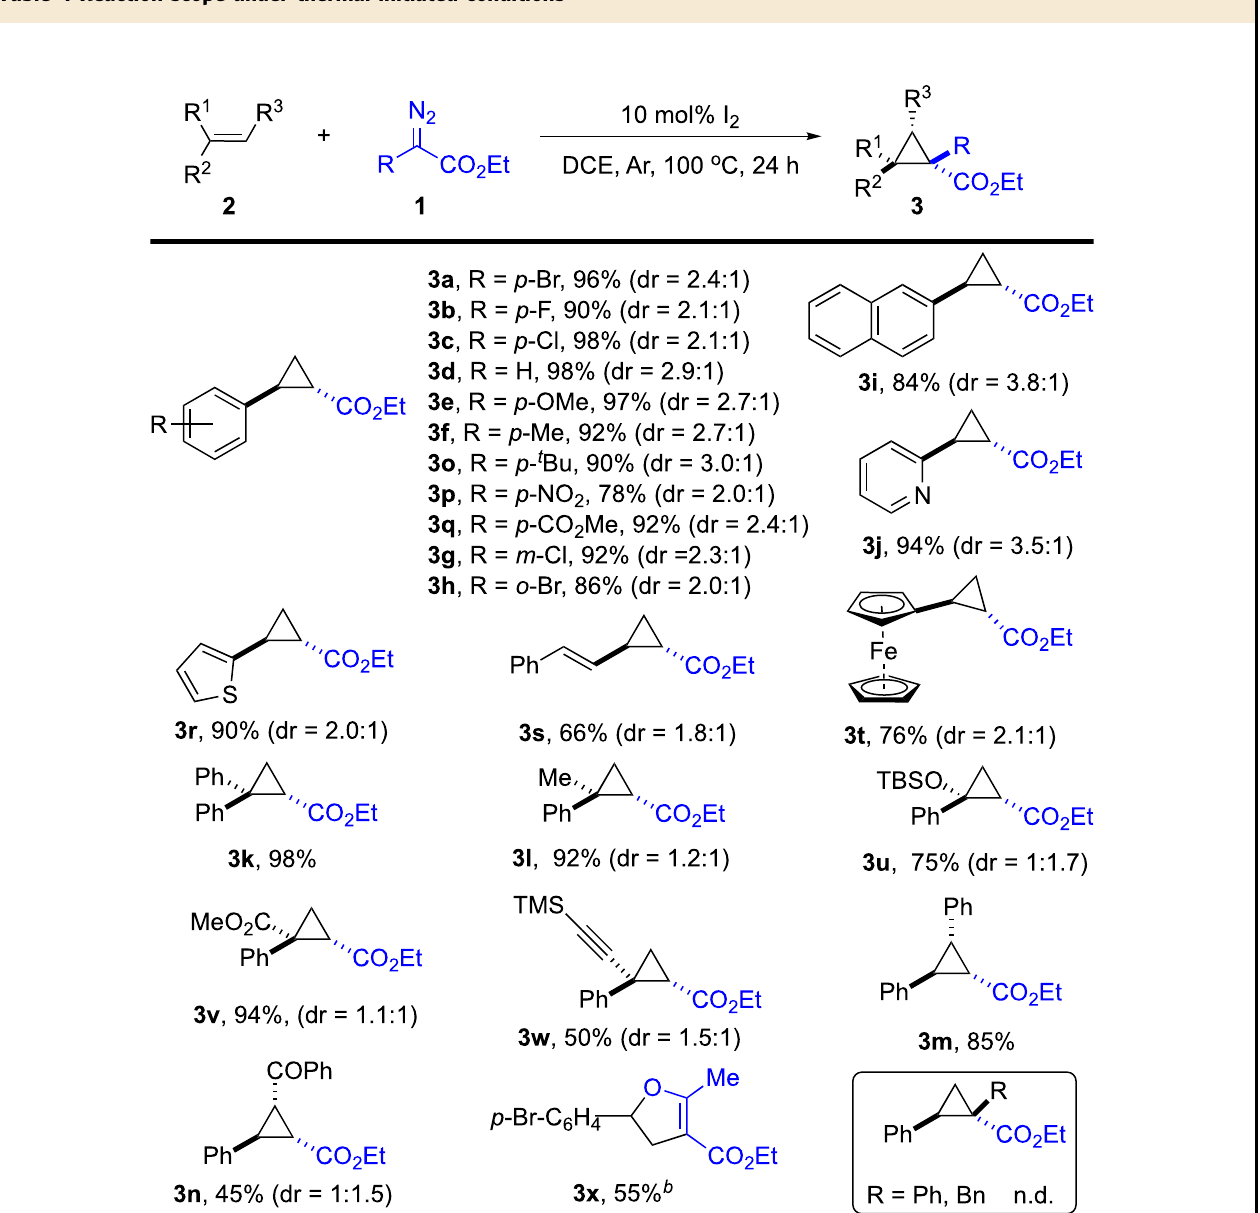
Table 4 Reaction scope under thermal-initiated